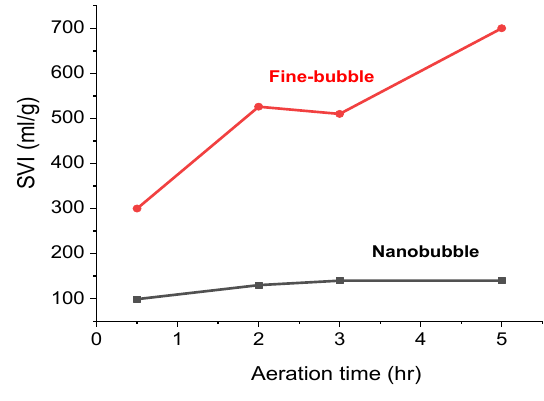
Fig. 7. Changes in SVI versus Aeration